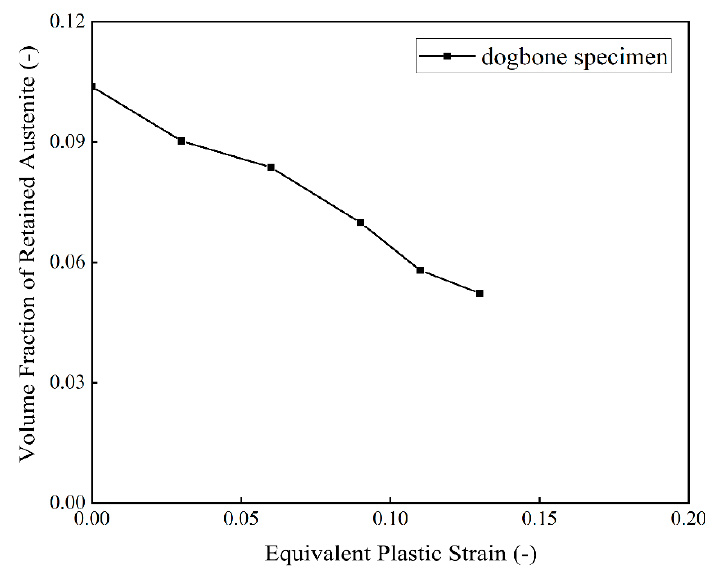
Figure 2. QP980 steel variation in retained austenite with EPS under uniaxial